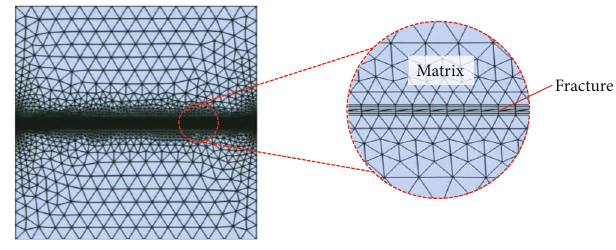
Figure 3: Mesh scheme of a single fracture model. Table 1: Physical parameters in models [12].